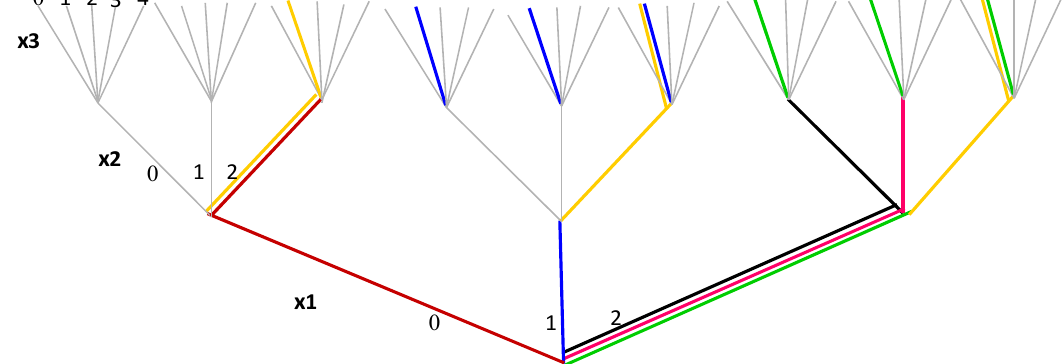
Figure 6. Logical tree with isolated branches.